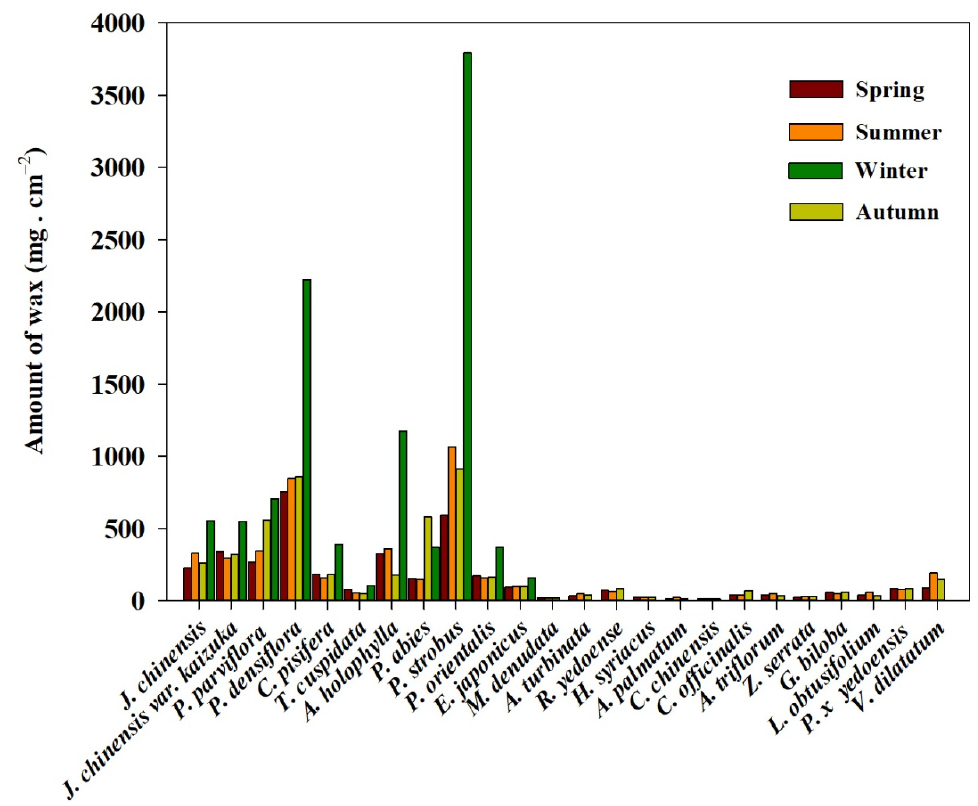
Figure 3. The amount of wax on 24 plant species in four seasons (spring, summer, autumn, and winter).